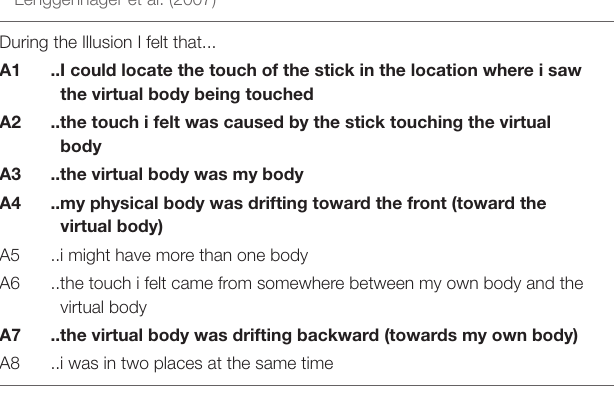
TABLE 1 | Questionnaires. Bold letters: means of responses p <